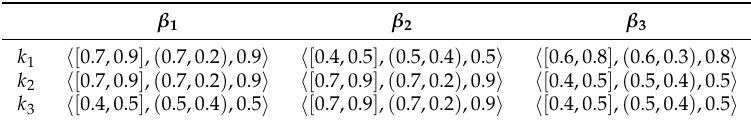
Table 3. Attribute rating in octahedron